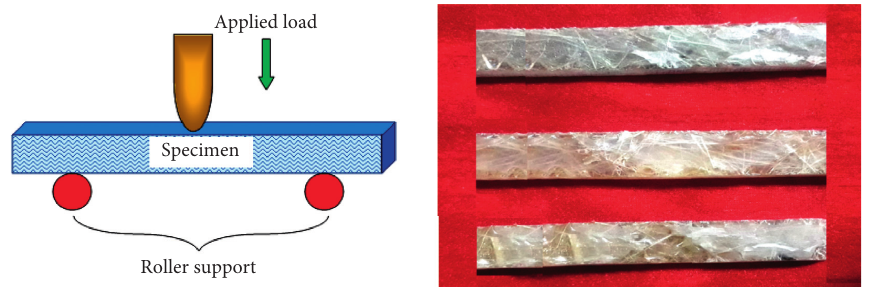
Figure 2: Three-point bending test arrangement with